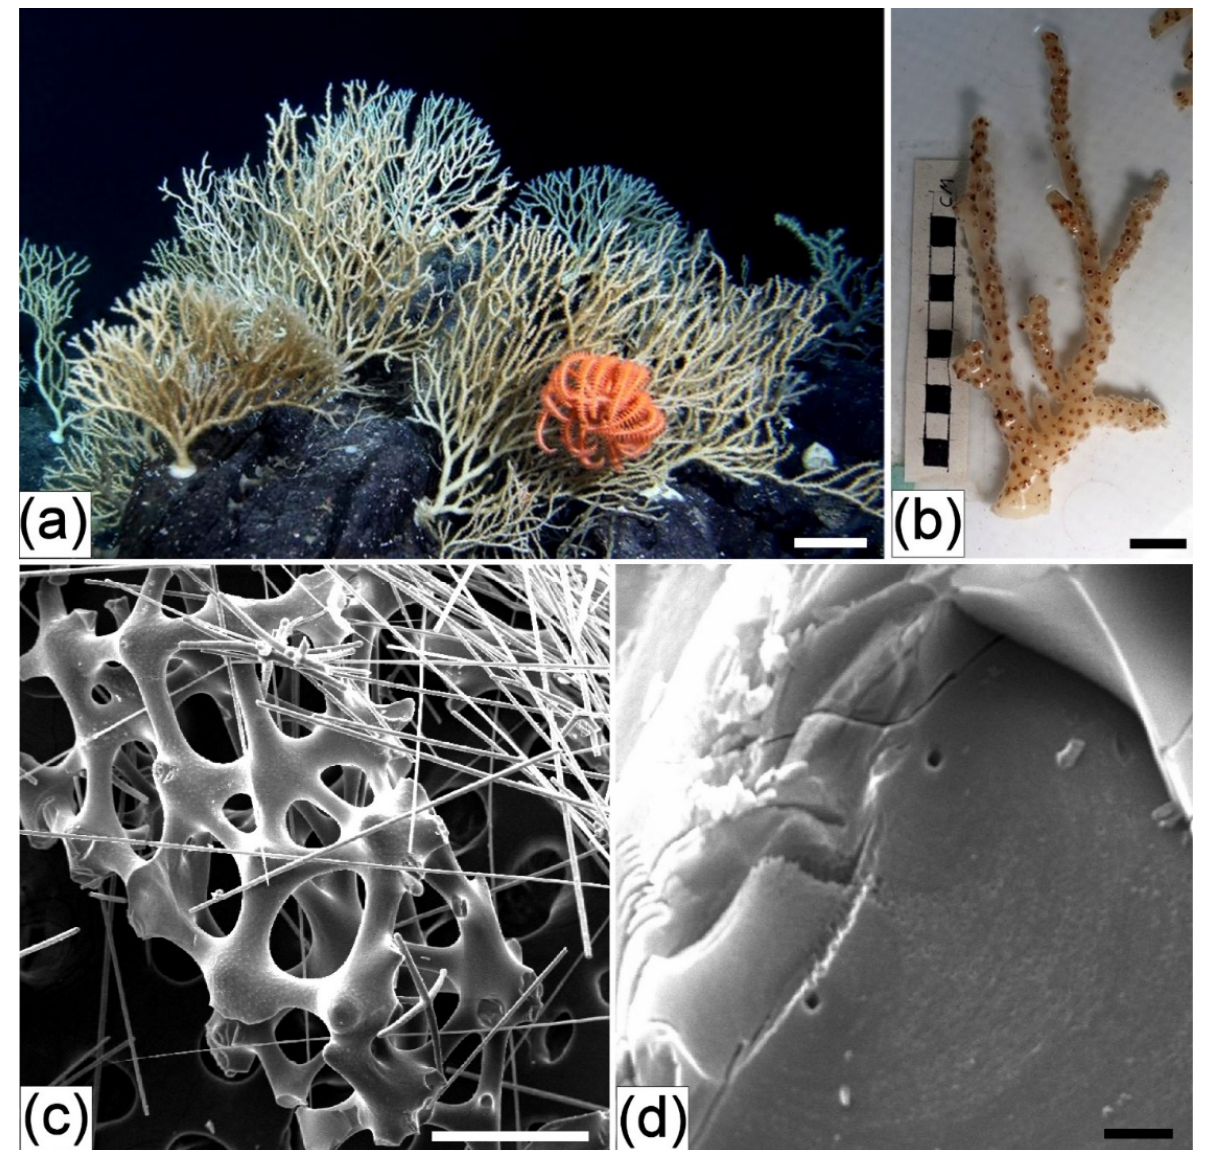
Figure 8. Sarostegia oculata. Morphological feature ( a , b ) and the ultrastructure of the spicules by SEM ( c , d ). Scale: ( a )—10 cm, ( b )—2 cm, ( c )—400 μ , ( d )—4 μ .